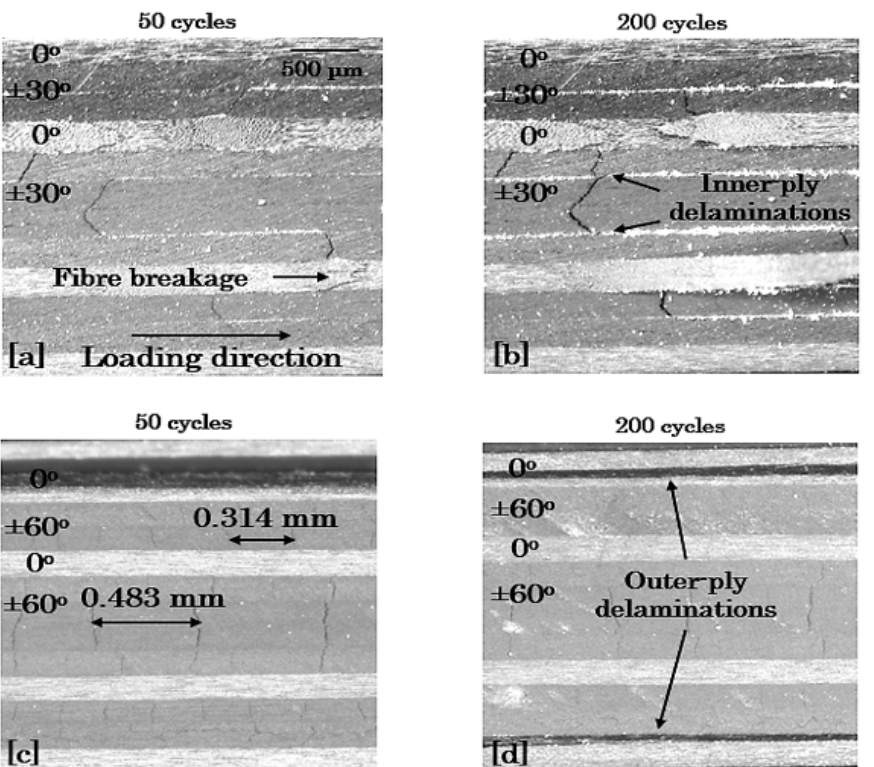
Figure 20. Damage in [0°/30°/ − 30°] 2s (top) and [0°/60°/ − 60°] 2s (bottom) laminates after ( a , c ) 50 and ( b , d ) 200 cycles for σ max = 0.8 × σ ult and R = 0.1.